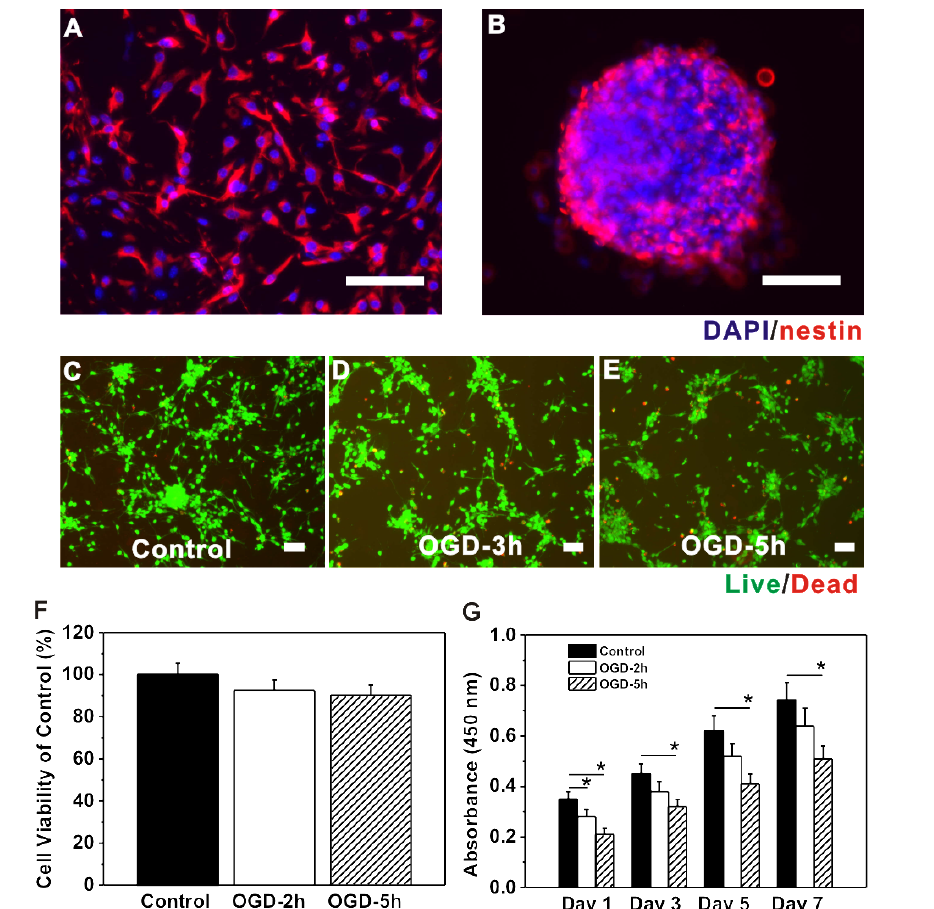
Figure 3. Cell viability and proliferation capacity of NSCs under OGD treatment. The fluorescent images of the adhered NSC (A) and the neurosphere (B). Nestin (red) and DAPI (blue) were used for immunostaining. (C-E) Cell viability assay of NSCs in control, OGD treated for 2 h and 5 h groups respectively as determined by live/dead assay. Live cells are stained green and dead cells are stained red. (F) MTT-measured viability of NSCs in these three groups. (G) Proliferation kinetics of NSCs were assessed at indicated time points in these three groups. Scale bar = 50 µm. Data were presented as mean ± S.E.M. *p < 0.05 vs